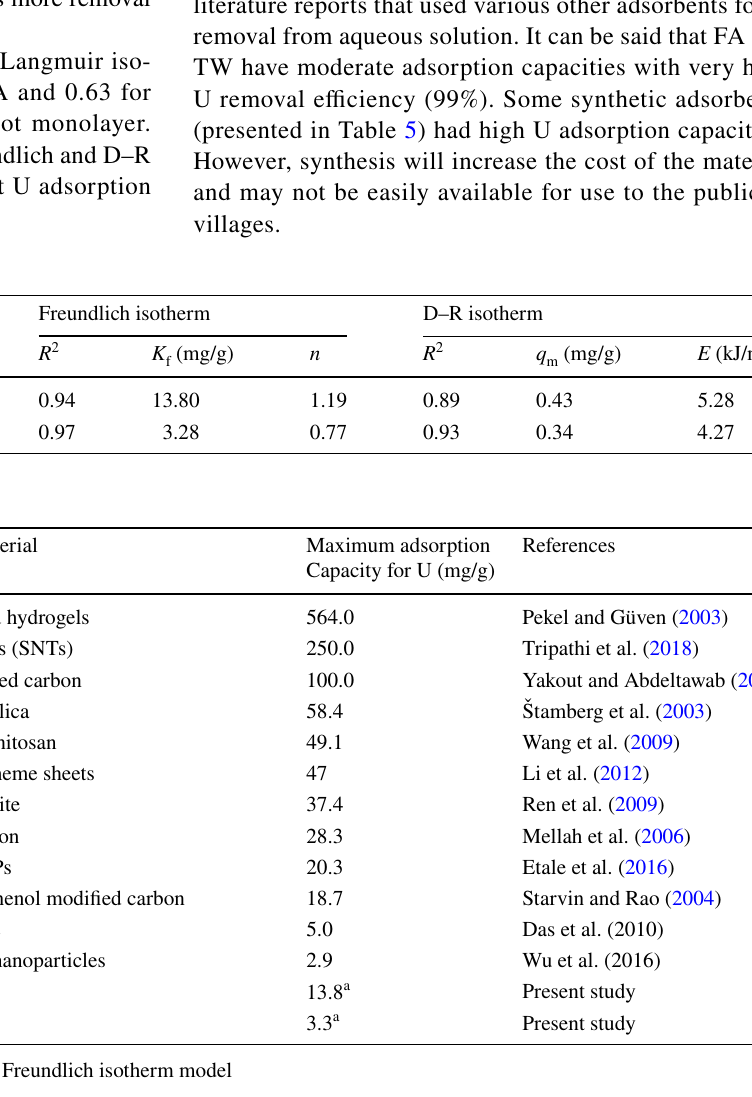
a Derived from Freundlich isotherm